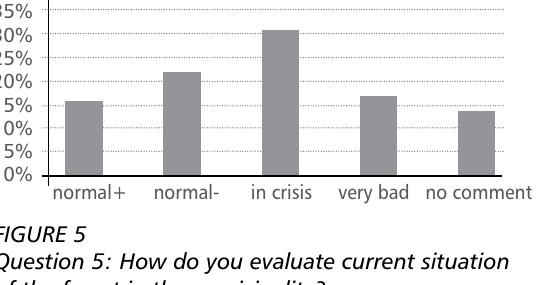
Question 7: How do you evaluate the work of the